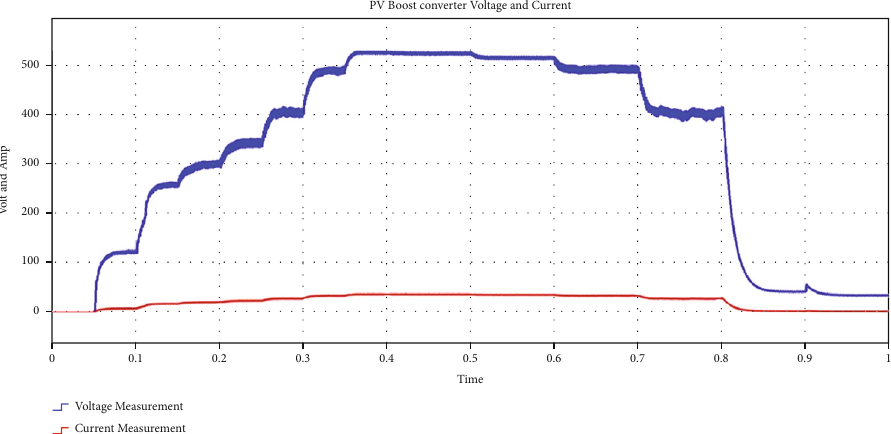
Figure 10: Simulation results of DNN-PV MPPT boost converter voltage and current with respect to irradiance and temperature.